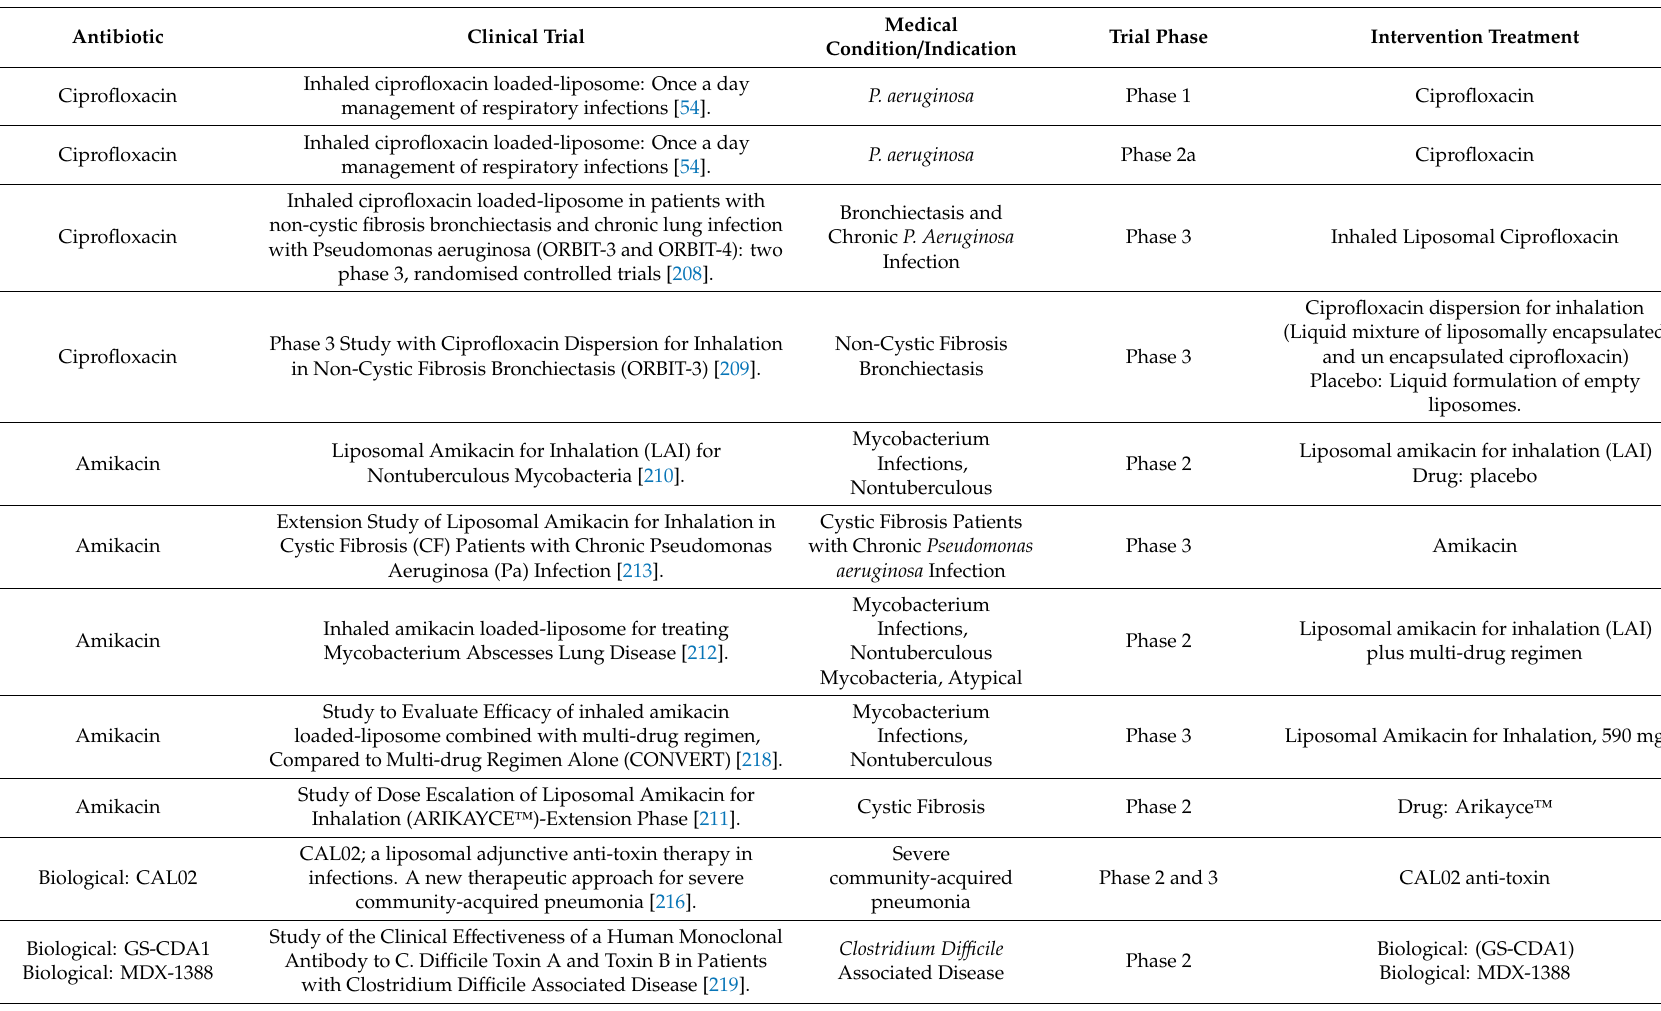
Table 5. Nanosystem-based antibiotics and anti-toxins in clinical trials di ff erent stages.